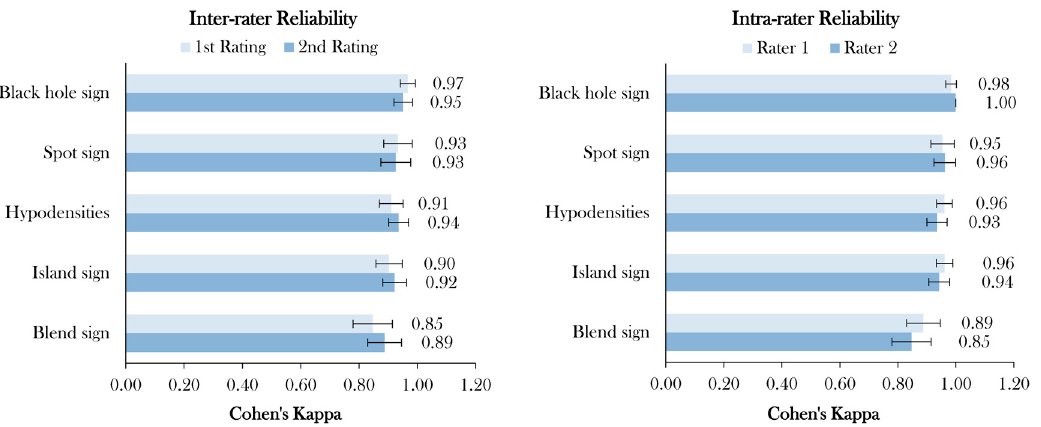
Figure 2. Inter- and intrarater reliability. Legend: Inter- and intrarater agreement of four noncontrast computed tomography imaging signs and spot sign on computed tomography angiography specified with stratified kappa with 95% confidence interval (CI) and listed in descending order; all p -values < 0.001. Table 4. Interrater agreement of two raters stratified across two readings.